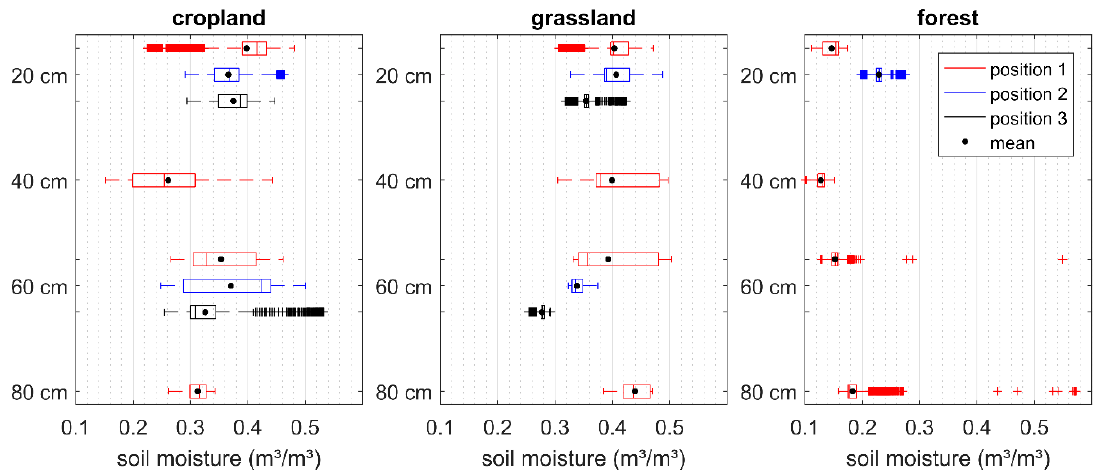
Figure 6. Comparison of the depth-dependent soil moisture distribution for the three land use types.